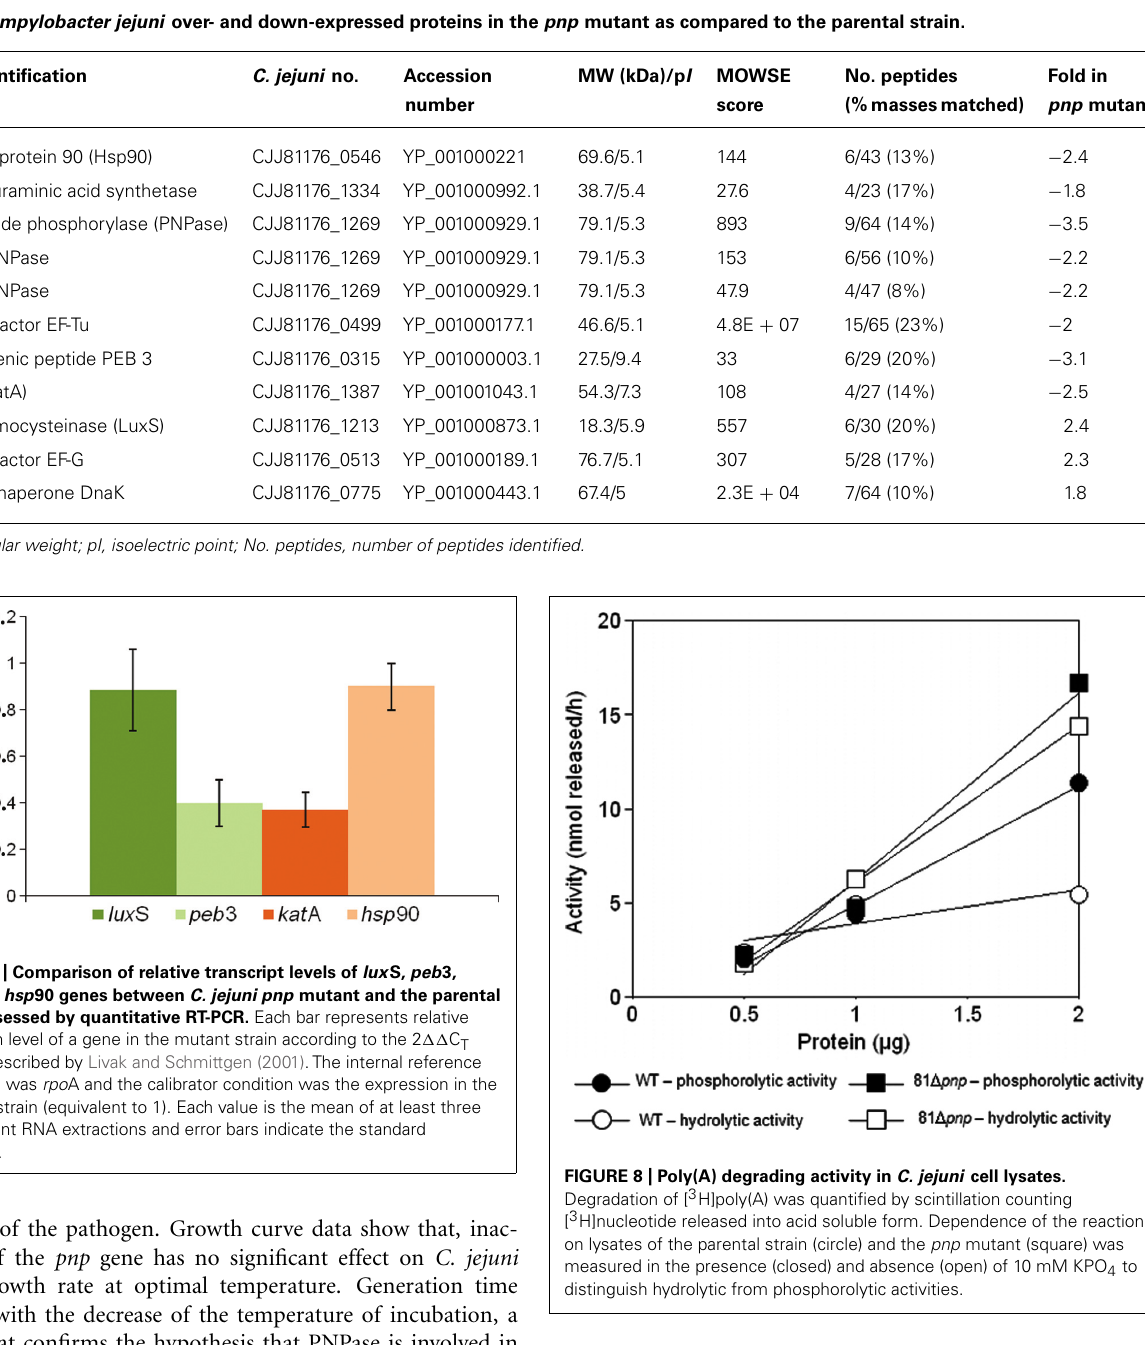
two strains verified the non-essential role of pnp gene in C. jejuni 81-176 strain, the majority of phosphorolytic ribonuclease activ- ity seems to depend on PNPase. Moreover, deletion of pnp gene increases hydrolytic ribonuclease activity. These results suggest that PNPase either down regulates, or antagonizes function, of a hydrolytic ribonuclease in C. jejuni . The enzyme responsible for hydrolytic poly(A) degrading activity is unknown, but com- parative sequence analysis predicts a single hydrolytic mRNA degrading exoribonuclease encoded by the C. jejuni genome, RNase